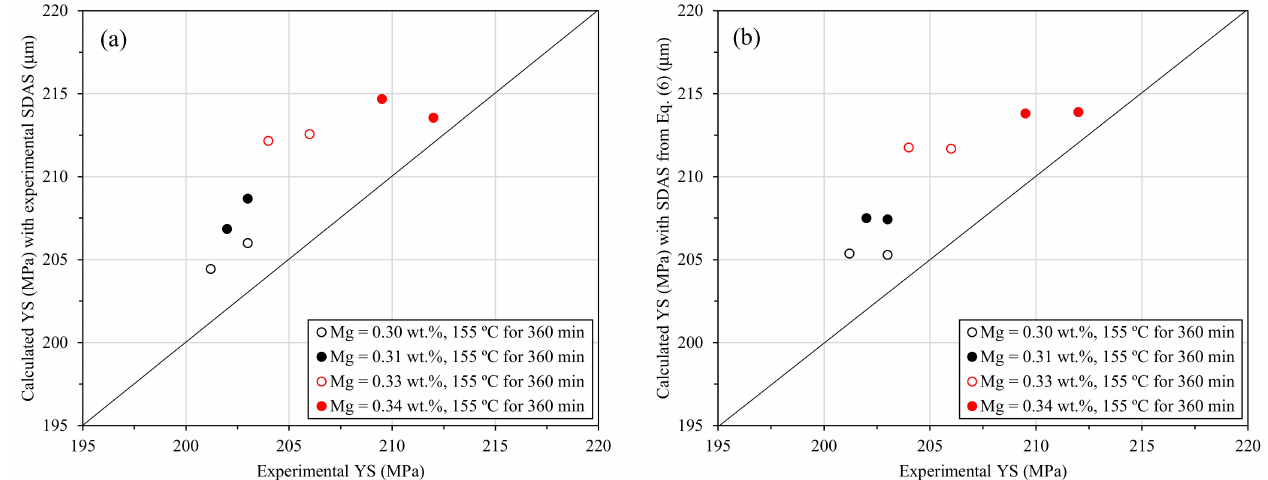
Figure 22. Comparison of experimental YS values obtained from the SK-8 castings and those pre- dicted by using Equation (28) and data included in Table 11. Two different SDAS parameters are used: experimentally measured SDAS ( a ) and the values of this parameter determined with Equation (6) ( b ). Black symbols correspond to SK-8 castings manufactured with 0.30 wt.% Mg (open circles) and with 0.31 wt.% Mg (solid circles) while red symbols correspond to castings produced with 0.33 wt.% Mg (open circles) and with 0.34 wt.% Mg (solid circles). All SK-8 castings were aged at 155 ◦ C for 360 min. Solid lines are the bisectors.